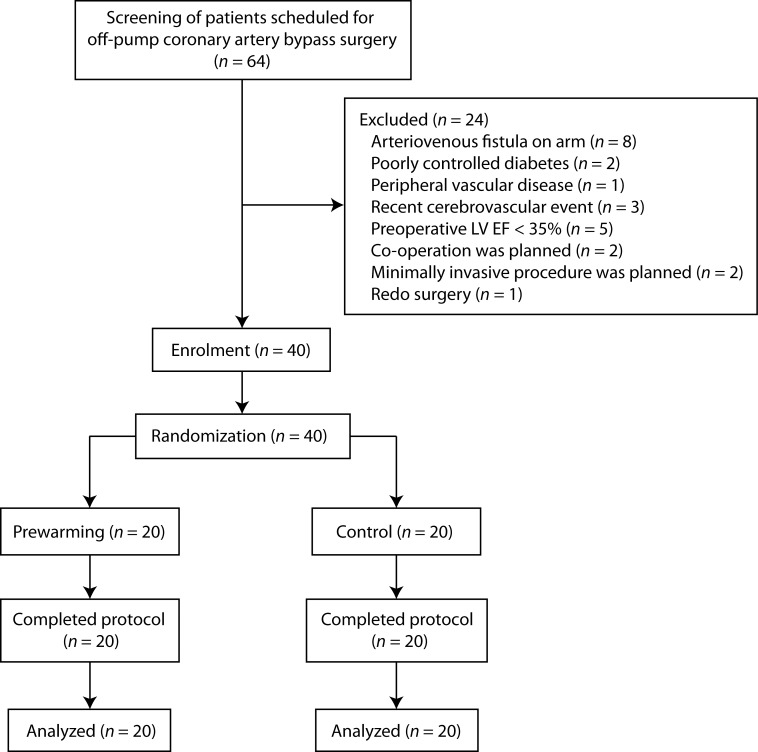
CONSORT flow diagram.